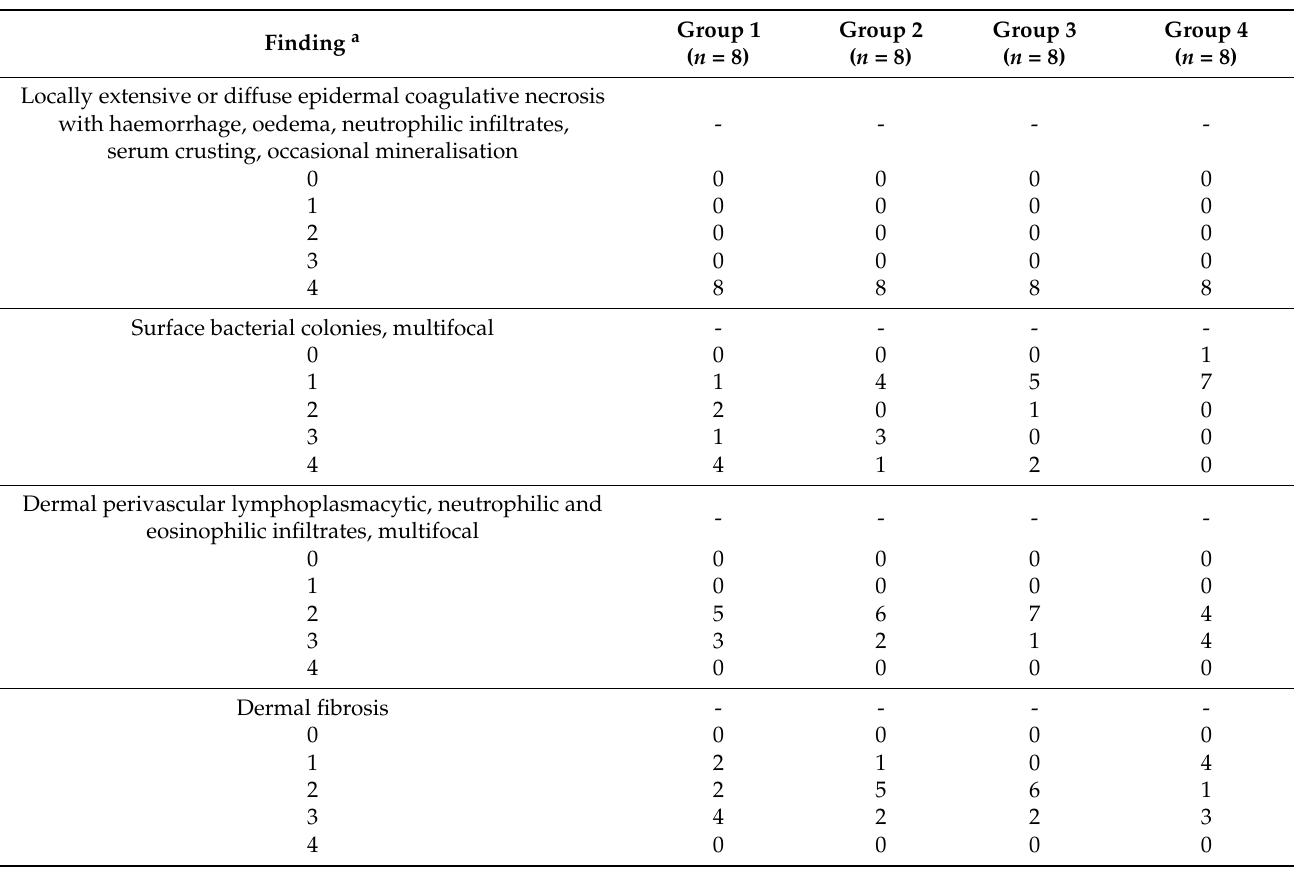
Dermal fibrosis - - - - 0